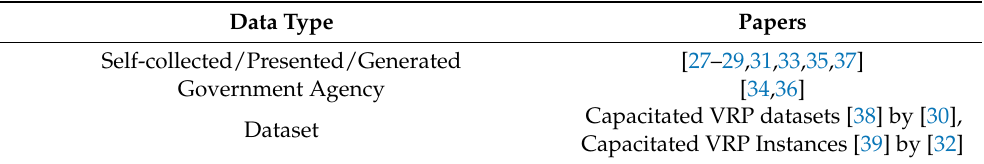
Table 4. Data setup used for Smart City Services